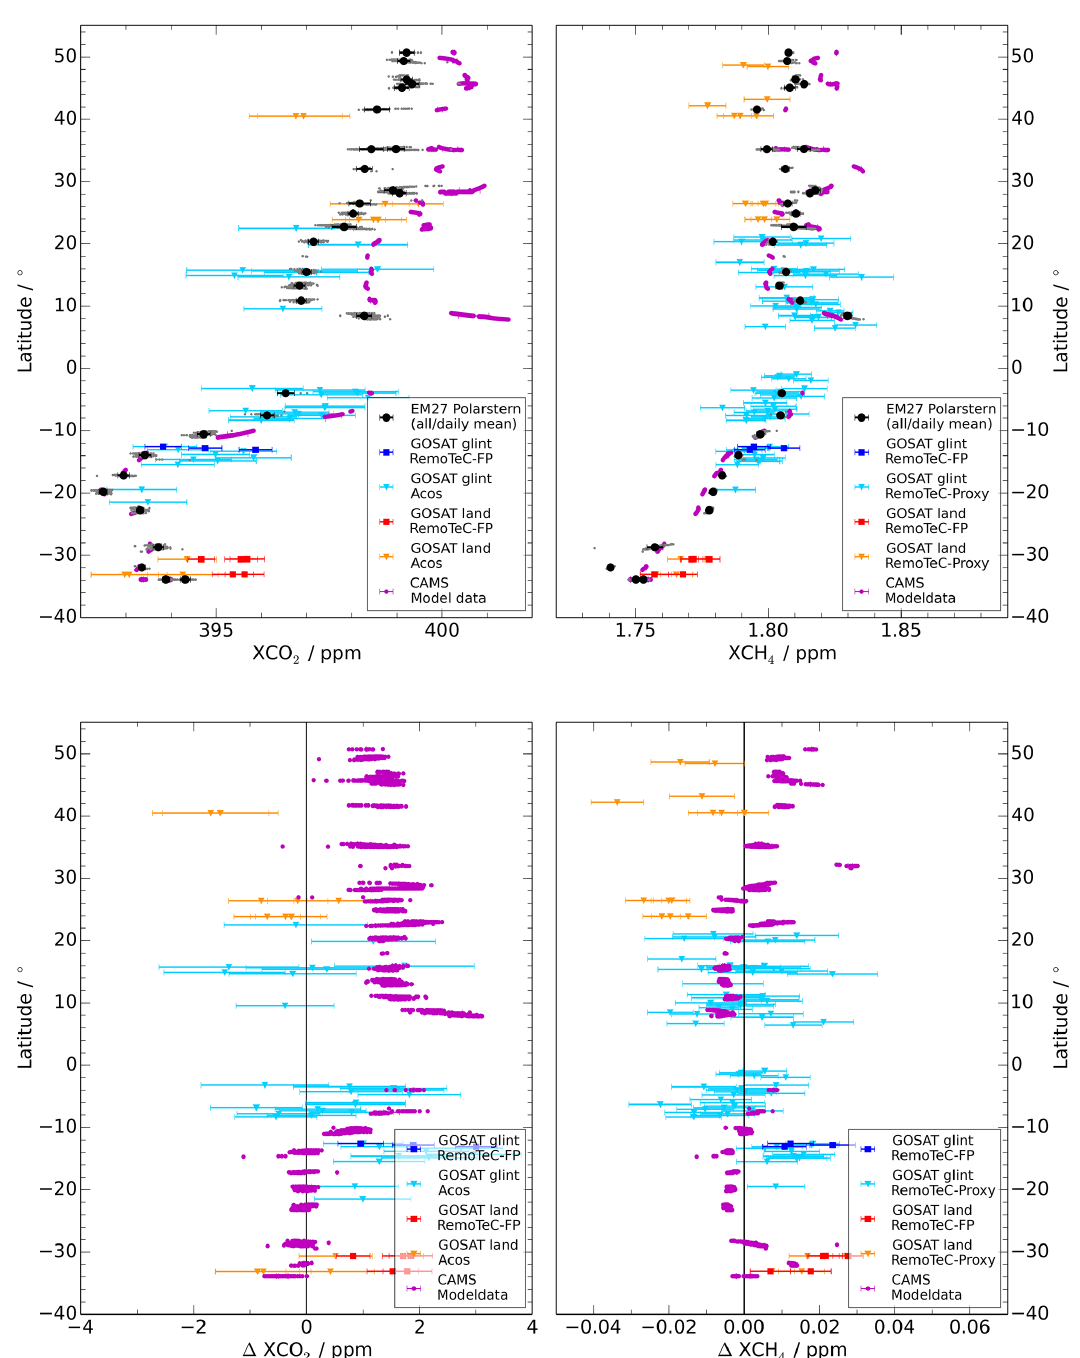
Figure 8. Latitudinal transects of XCO 2 (left) and XCH 4 (right) for the ship-borne EM27/SUN measurements (daily averages: black dots; all data: gray dots) and various correlative data sets (top) as well as differences of the latter to our ship records (bottom). For XCO 2 , correlative data sets are the RemoTeC-FP retrievals from GOSAT (ocean glint: blue; land nadir: red), the ACOS retrievals from GOSAT (ocean glint: light blue; land nadir: orange), and XCO 2 modeled by the CAMS model (purple). For XCH 4 , correlative data sets are the RemoTeC-FP retrievals from GOSAT (ocean glint: blue; land nadir: red), the RemoTeC-proxy retrievals from GOSAT (ocean glint: light blue; land nadir: orange), and XCH 4 modeled by the CAMS model (purple). For GOSAT, soundings are coincident whenever they are conducted within 5 ◦ latitude/longitude of the ship track and within a ± 4h time frame. XCO 2 and XCH 4 differences shown in the lower panels are calculated according to (cid:49) = X −(cid:104) X EM27 (cid:105) 4h where the brackets indicate averaging over